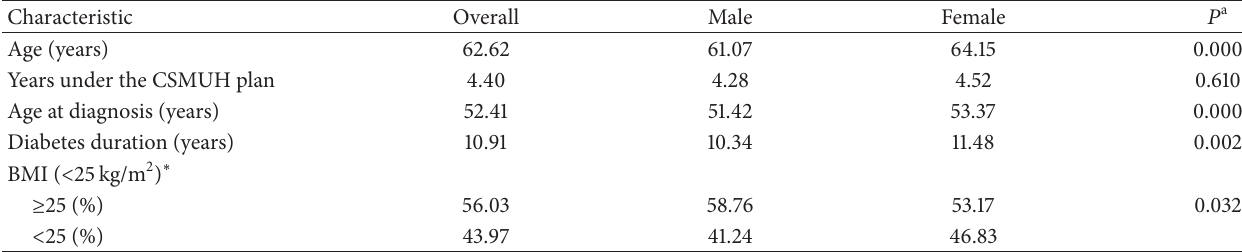
Table 1: Characteristics of male and female patients in the year of